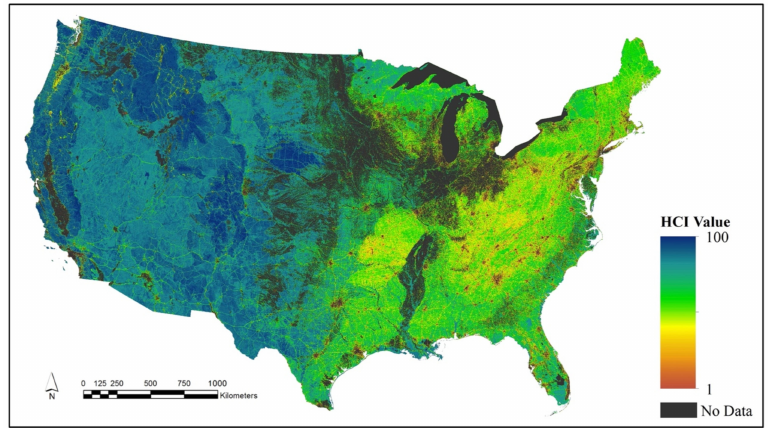
Figure 4. The Habitat Condition Index (HCI) shows landscape-scale habitat quality for the CONUS. Blue represents the highest quality as assessed by our method, with green and yellow being of intermediate quality, and red being the lowest quality. Areas in black are land cover types for which we could not acquire adequate test data to calibrate or validate the map, most commonly urban, intensive row crops, or large water